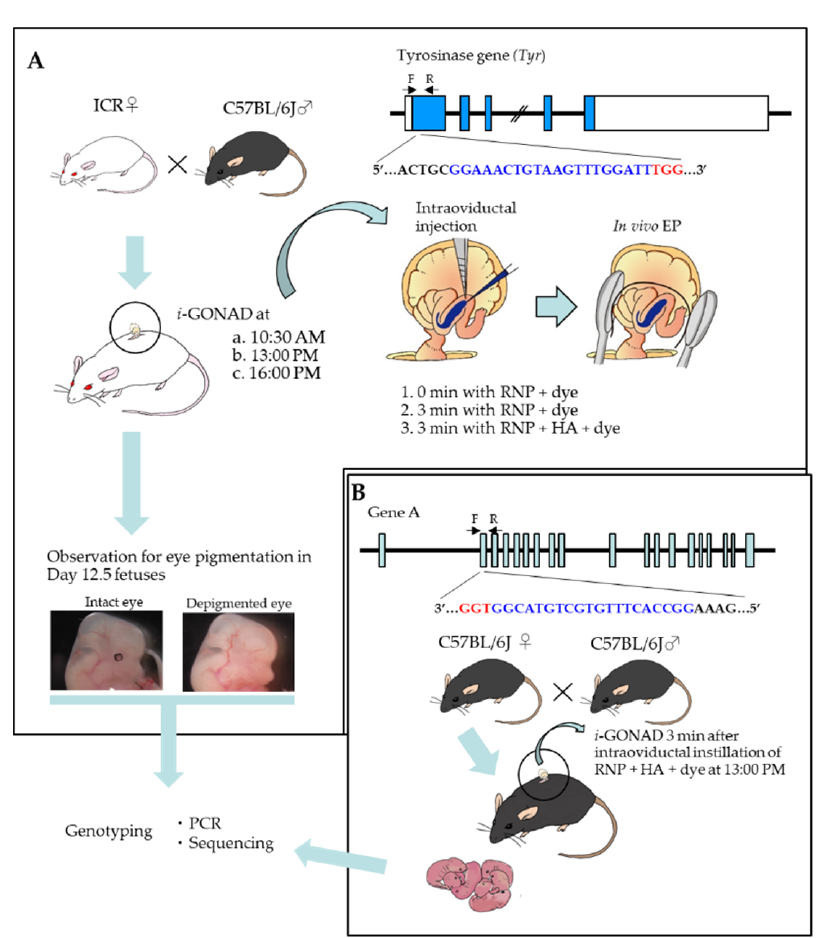
Figure 1. Experimental outline of i- GONAD performed toward zygotes at various times using different conditions and reagents. ( A ). i- GONAD-mediated disruption of tyrosinase gene ( Tyr ). One day before i -GONAD, female ICR mice are naturally mated to male C57BL/6J mice. The next day, the ICR females showing successful pregnancy, which can be judged by the presence of copulation plugs in the vagina, were subjected to i -GONAD at various times (10:30 a.m., 13:00 p.m. and 16:00 p.m.) using different conditions (in vivo electroporation (EP) immediately (0 min) after intraoviductal instillation of ribonucleoprotein (RNP) + Fast Green FCF (dye), which is defined as “0 min with RNP + dye”, in vivo EP 3 min after intraoviductal instillation of RNP + dye, which is defined as “3 min with RNP + dye” or in vivo EP 3 min after intraoviductal instillation of RNP + hyaluronidase (HA) + dye, which is defined as “3 min with RNP + HA + dye”. At Day 12.5 of pregnancy, mid-gestational fetuses are dissected from the i- GONAD-treated females to check the presence of de-pigmented eyes and subsequent genotyping. The sequence recognized by gRNA is shown in blue and protospacer adjacent motif (Pa.m.) by red. ( B ). i- GONAD-mediated disruption of Gene A. In a case of disruption of Gene A, in vivo EP was performed on the pregnant B6 females at Day 0.5 of pregnancy 3 min after intraoviductal instillation of RNP (targeted Gene A) + HA + dye. Then, the i- GONAD-treated females were allowed to survive for delivering their pups. The sequence recognized by gRNA is shown in blue and protospacer adjacent motif (Pa.m.) in